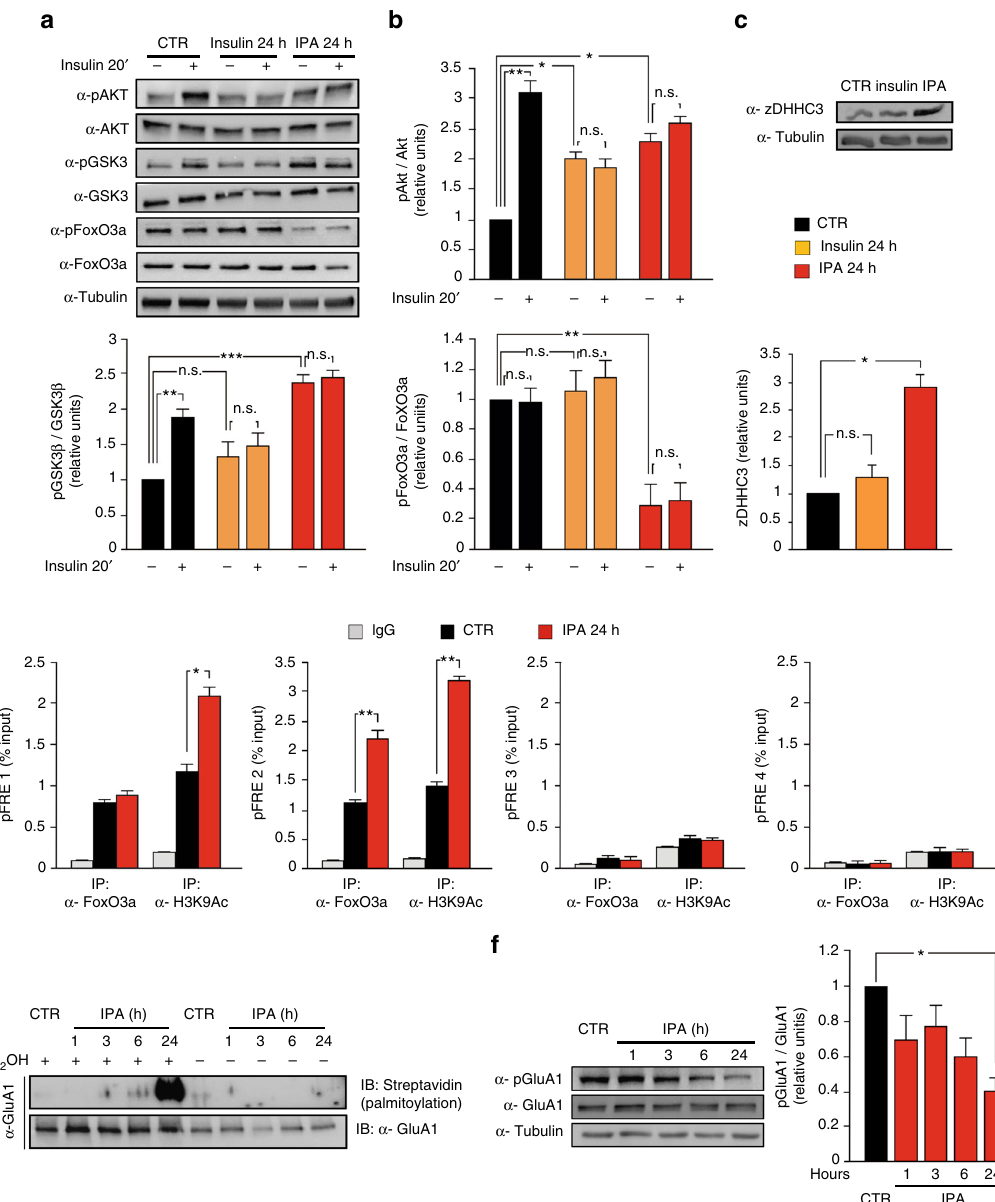
Fig. 3 Insulin and palmitic acid (IPA) transcriptionally induce zDHHC3 and affect palmitoylation and phosphorylation of GluA1 in hippocampal neurons. a Immunoblots of pGSK3 β Ser 9 and pFoxO3a Ser 253 after 24 h of insulin or IPA treatment and upon acute stimulation with insulin. b Densitometry of pAkt Ser 473 (top), pGSK3 β Ser 9 (bottom, left), and pFoxO3a Ser 253 (bottom, right) blots, normalized to both the corresponding total protein and tubulin; experiments were performed in triplicate (statistics by two-way ANOVA and Bonferroni post hoc). c Immunoblots (top) and densitometry (bottom) of zDHHC3 expression after insulin or IPA treatment; experiments were performed in triplicate (statistics by one-way ANOVA and Bonferroni post hoc). d Chromatin immunoprecipitation assays of FoxO3a binding to and histone H3 lysine 9 acetylation (H3K9Ac) of putative FoxO3a responsive elements (pFRE) around the zDHHC3 promoter in hippocampal neurons treated with vehicle (CTR) or IPA (statistics by Mann – Whitney test). Data represent mean values of three independent experiments. e Immunoblots of palmitoylated GluA1 (top) and total immunoprecipitated protein (bottom) in hippocampal neurons. Samples without NH 2 OH are negative controls. The experiment was repeated three times with similar results. f Immunoblots of pGluA1 Ser 845 (left) and densitometry of pGluA1 Ser 845 normalized to both total GluA1 and tubulin (right). The experiment was repeated three times ( n = 3, statistics by one-way ANOVA and Bonferroni post hoc). Data are shown as mean ± SEM.* p < 0.05; ** p < 0.01; *** p < 0.001; n.s. not signi fi the membrane impermeant cross-linking reagent bis (sulfo- + 48.5 ± 6.7% and [S] − 26.8 ± 5.6% vs. control; Fig. 4a, b). We succinimidyl) suberate (BS 3 ). BS 3 is a cross-linking agent that also performed GluA1 immunostaining without membrane per- forms clusters of GluR subunits expressed on the cell surface 27 . meabilization in order to speci fi cally detect the fraction of The following SDS-PAGE assay revealed an abundance of GluA1 receptors localized on the membrane. Accordingly, upon IPA cytoplasmic monomers (indicated with [C]) and a signi fi cant treatment, surface GluA1 content notably decreased in neurites decrease of plasma membrane receptor tetramers containing ( − 44%; Fig. 4c and Supplementary Fig. 3c), whereas GluA1 fl uorescence intensity increases in the Golgi apparatus (+25%; GluA1 (indicated with [S]) in neurons stimulated with IPA ([C]